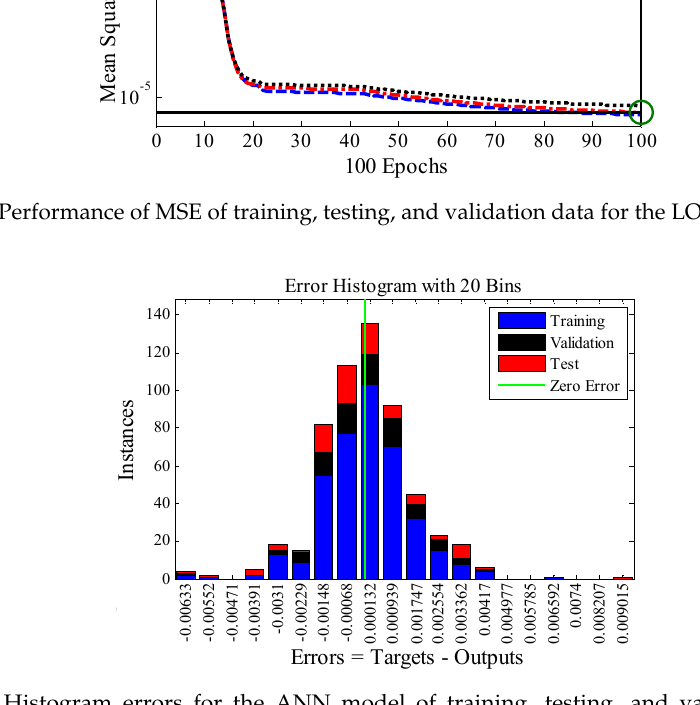
Figure 17. Histogram errors for the ANN model of training, testing, and validation data for LOS environments.